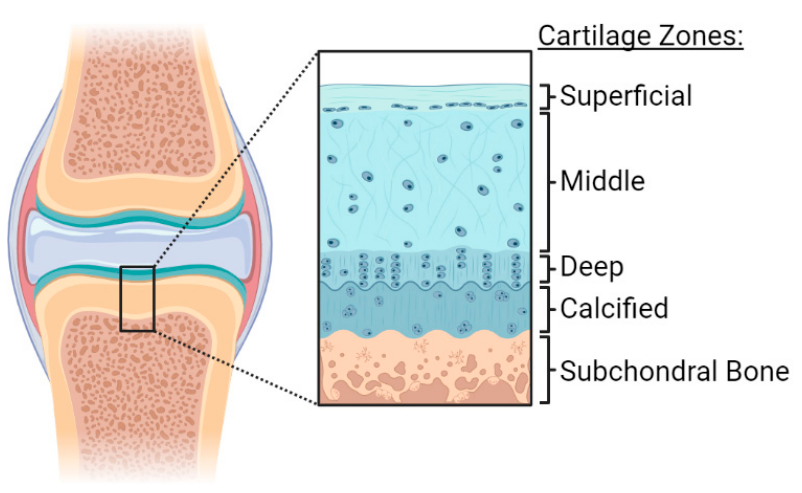
Figure 2. Articular cartilage organization. The structure of the articular cartilage is organized into three distinct zones: the superficial, middle, and the deep zones. Calcified cartilage lies between the subchondral bone and the deep zone. Created with BioRender.com.